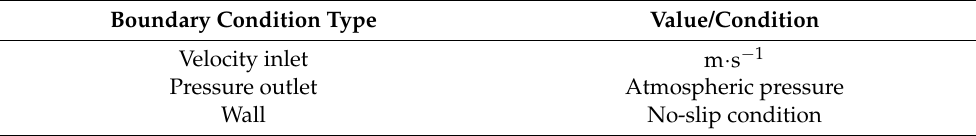
Table 2. Boundary conditions.